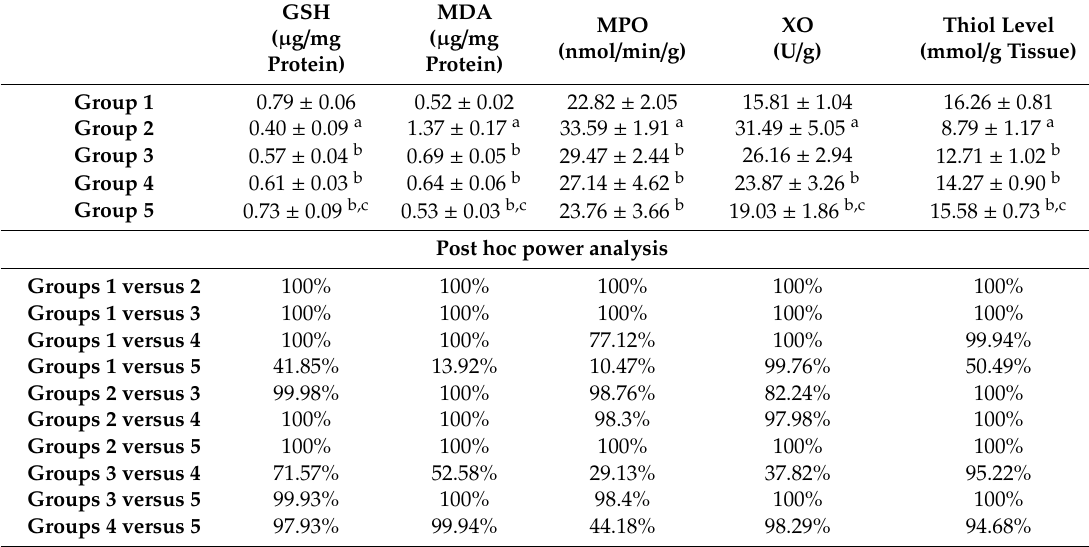
Table 1. The e ffi cacy of chitosan and lecithin against oxidative and the antioxidant status in the osteoarthritis (OA) model that was induced by monoiodoacetate (MIA). MDA GSH ( µ g / mg ( µ g / mg Protein)